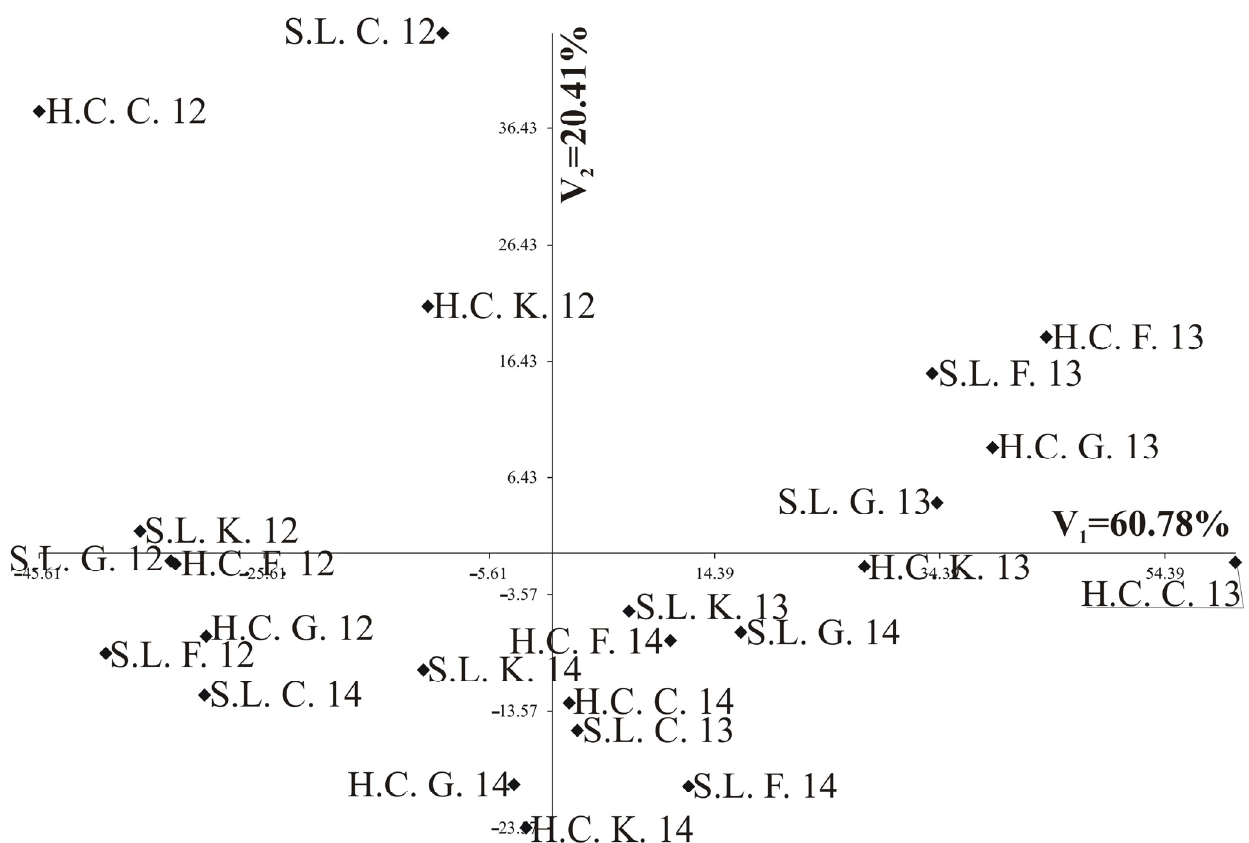
Figure 4. Distribution of combinations of treatments in the two first canonical variates. Abbreviations: S.L.—Stagnic Luvisolor, H.C.—Haplic Cambisol; C.—‘Celer’, F.—‘Furman’, G.—‘Grajcar’, K.—‘Kasztan’; 12–14—years 2012–2014.